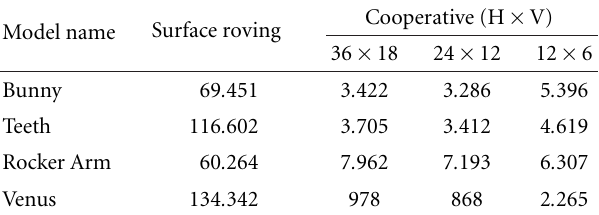
Table 1: The number of observations for surface roving and coop- erative methods.